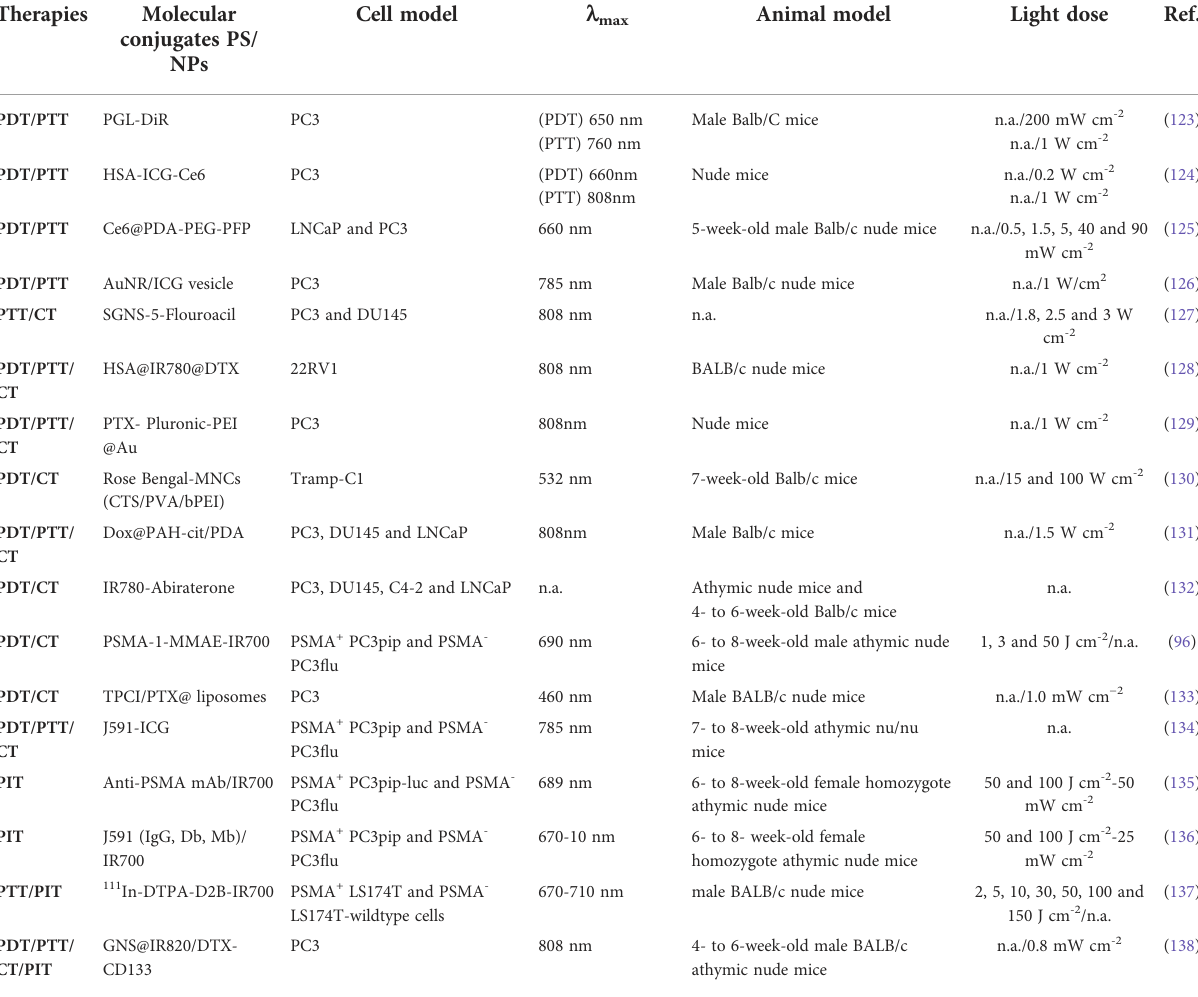
TABLE 5 Different therapies studies combine with PDT for prostate cancer.